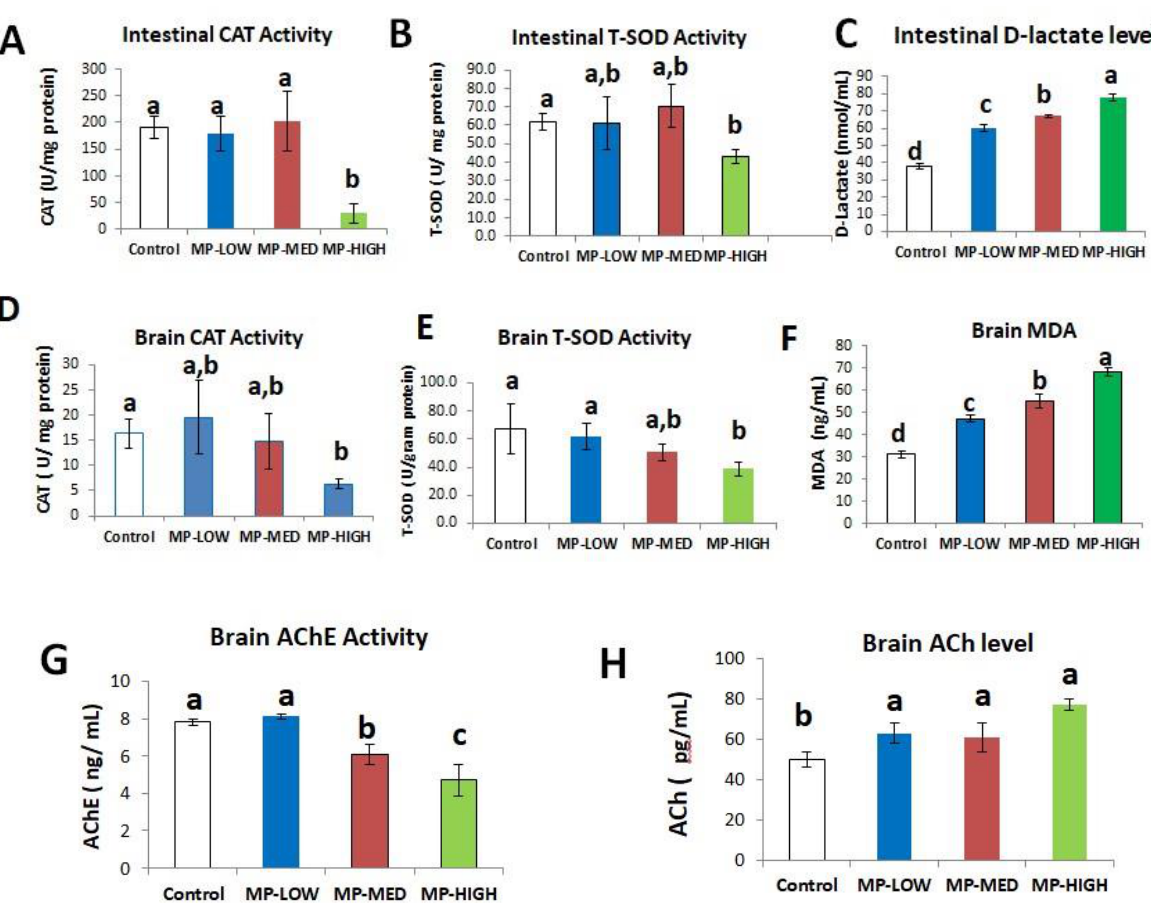
Figure 7. Bar charts of biomarkers of intestinal oxidative stress ( A , B ), intestinal permeability ( C ), brain oxidative stress ( D , E ), lipid peroxidation ( F ) and neurotoxicity ( G , H ). Groups with different alphabets denotes significant difference ( p -value < 0.05). Data presented in mean ± SD of 4 biological replicates.